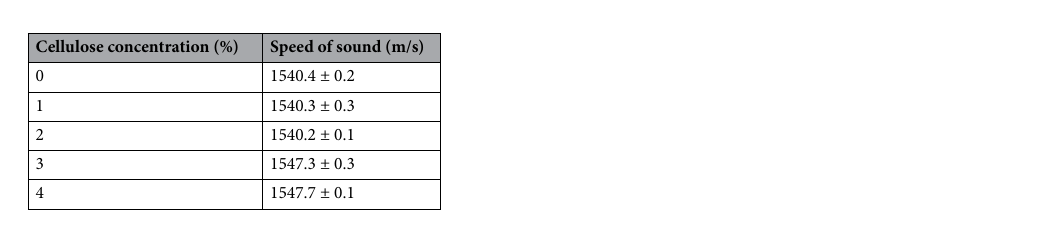
Figure 4. US images acquired at varying cellulose concentration without added sucrose (Panel A ): ( a ) 0%, ( b ) 1%, ( c ) 2%, ( d ) 3%, and ( e ) 4%; as well as at varying sucrose concentration for a fixed 1% cellulose (Panel B ): ( a ) 0%, ( b ) 10%, and ( c ) 20%.